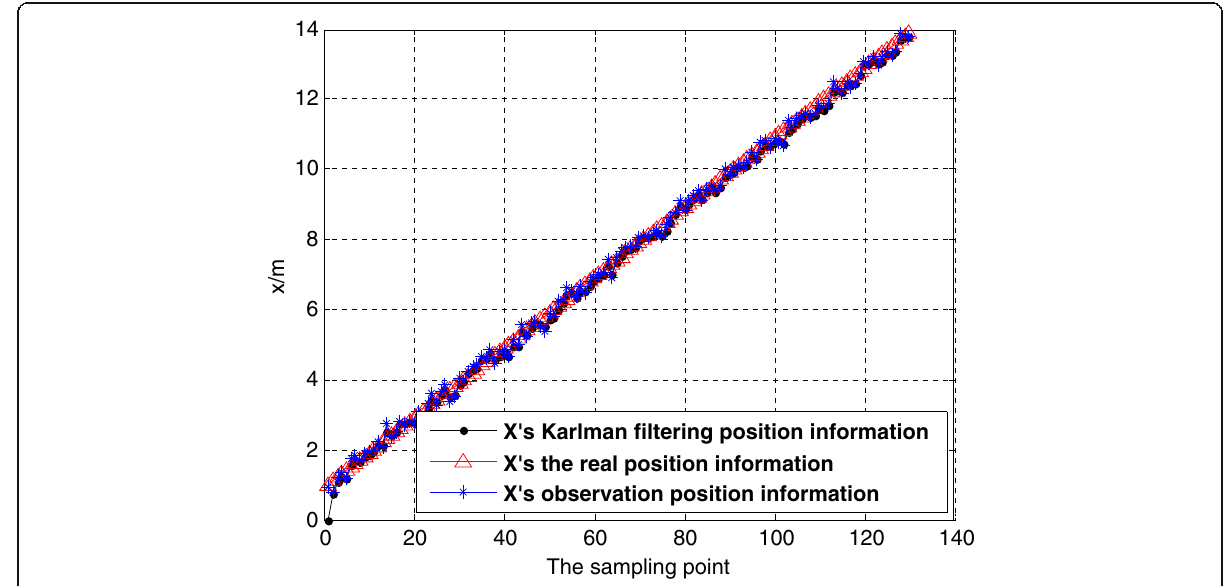
Fig. 6 Uniform motion X direction